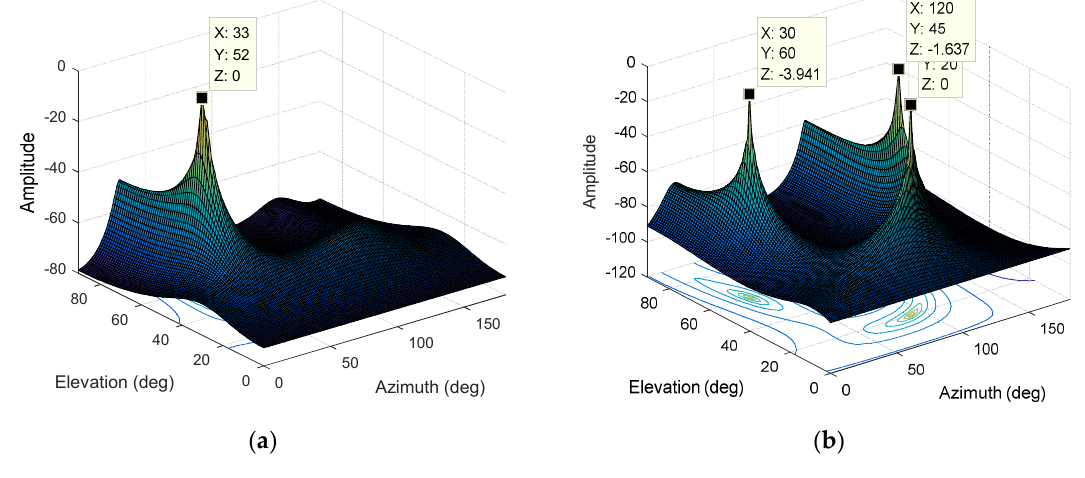
( b ) Figure 9. The normalized spectral function. ( a ) The normalized spectral function derived from the MUSIC algorithm ( 4 M  , 2 K  ); ( b ) The normalized spectral function derived from the STC-MUSIC algorithm (